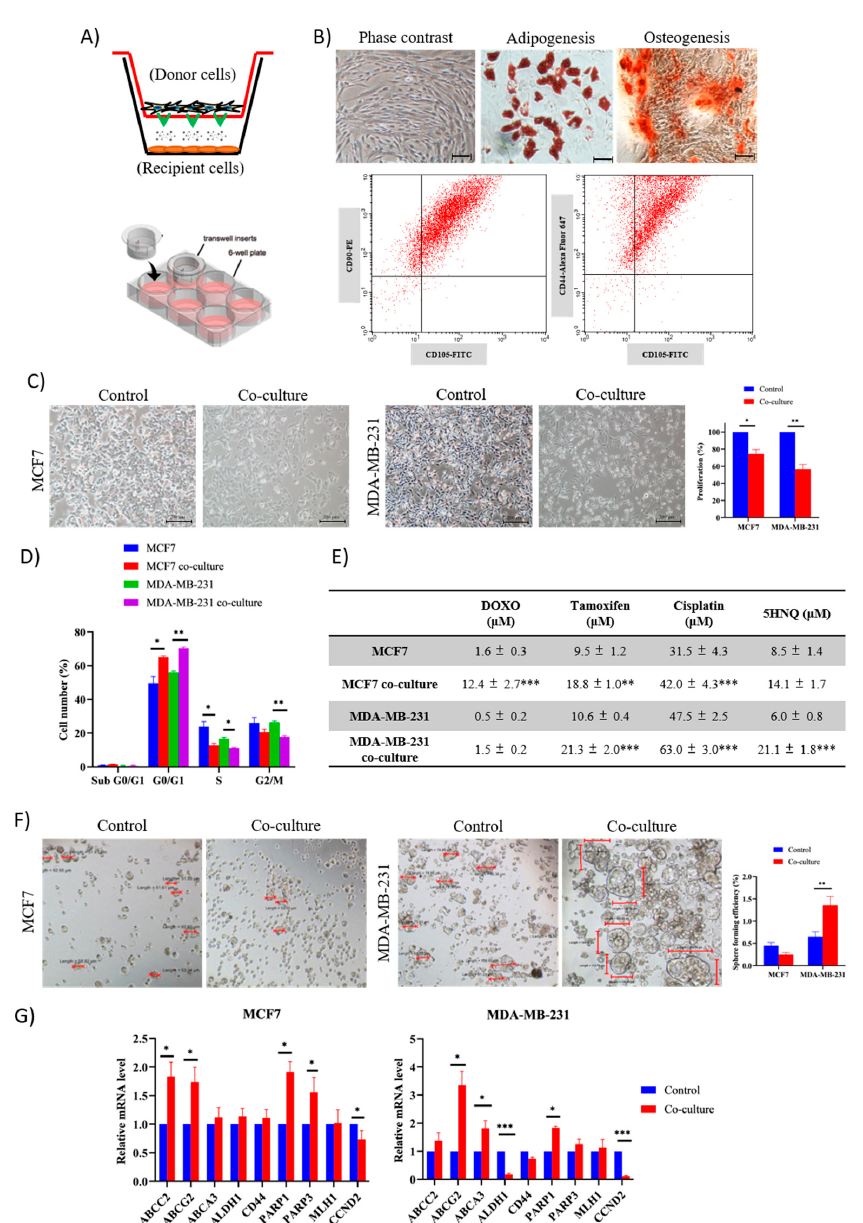
Figure 1. The inhibition effects of co-culture mesenchymal stem cell (MSC) on human breast cancer cell lines (BCCs) progression. ( A ) Schematic representation of Transwell indirect co-cultures between BCCs and adipose MSC containing polycarbonate membranes 1.0 μ m pore size. ( B ) Characterization of adipose MSCs. Primary adipose MSCs after reaching confluence at passage 5. Adipogenic and osteogenic differentiation stained with Oil Red O dye to visualize the lipid droplets and Alizarin Red dye following differentiation. Scale bar = 100 μ m. Representative graphs of adipose MSCs immunophenotyping were all positive for CD105, CD90 and CD44. ( C ) Inhibition of cancer cell proliferation (10× magnification). ( D ) Cell cycle G0/G1 phase arrest. ( E ) Decreased sensitivity to chemotherapy drugs (IC50 values of drugs in co-culture treated cells increased after 48 h of incubation). ( F ) Mammary tumors sphere formation in 3D culture (10× magnification). ( G ) Dysregulation of multiple drug resistance (MDR), cancer stem cell (CSC) and DNA repair genes expression. The results were analyzed using a t-test with mean values ± SD. * p < 0.05, ** p < 0.01 and *** p < 0.001 compared with the non-co-culture group.